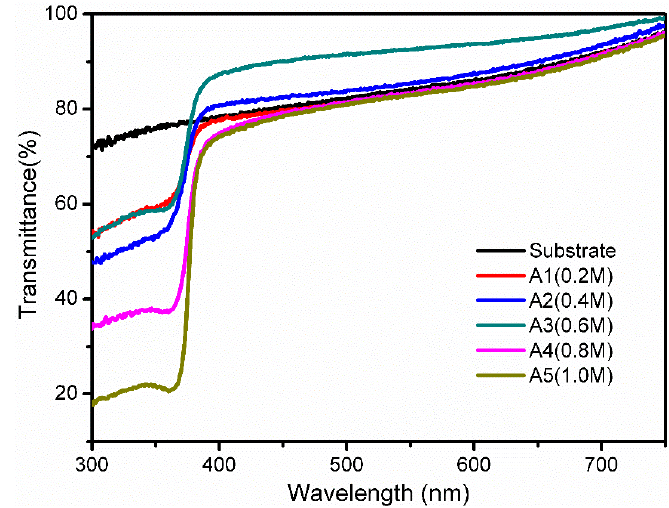
Figure 8. Transmittance spectra of the ZnO films deposited with different sol concentrations.